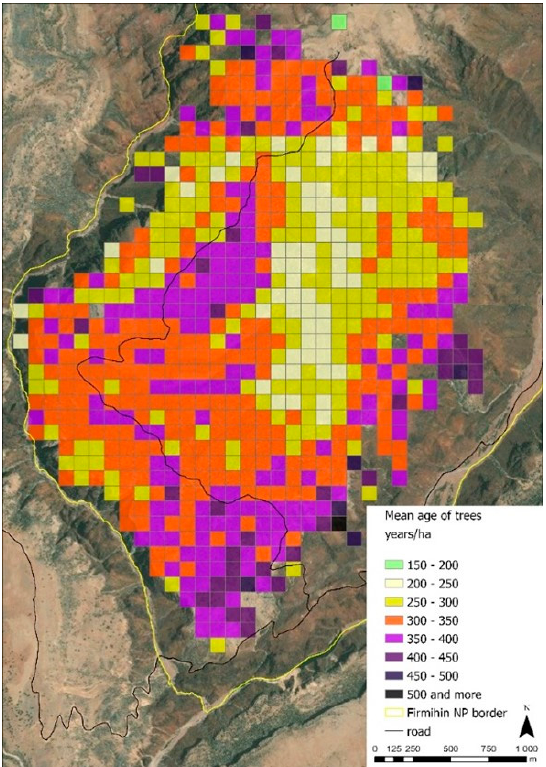
Figure 7. Spatial distribution of Dracaena estimated tree ages in Firmihin (tree ages /ha).